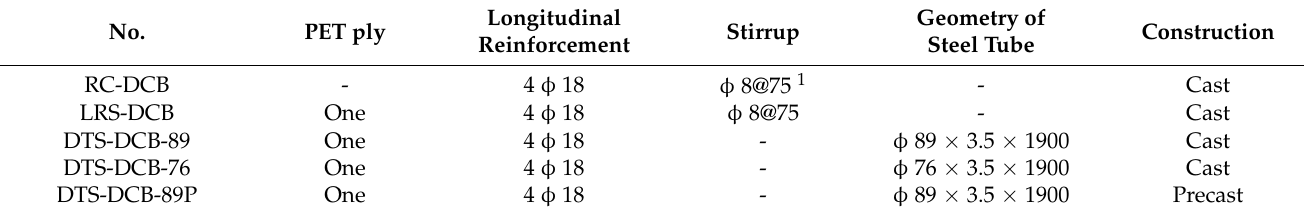
Figure 1. Specimen design: ( a ) large rupture strain double coupling beam (LRS-DCB); ( b ) double-skin tubular double coupling beam (DST-DCB).